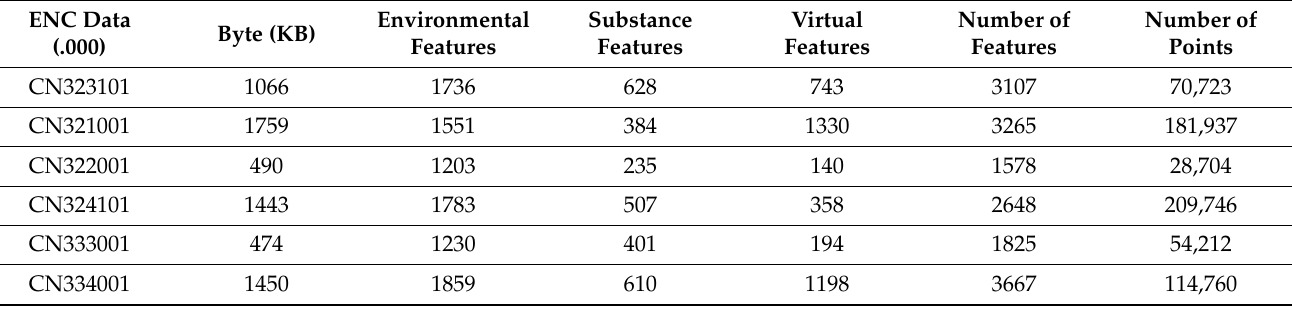
Table 2. The information of the